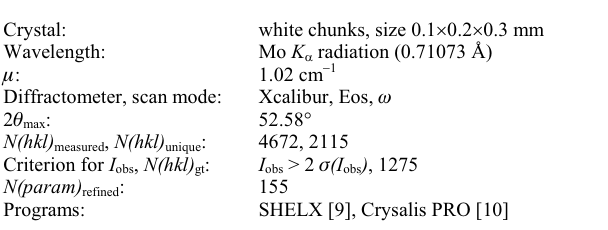
Table 1. Data collection and handling.